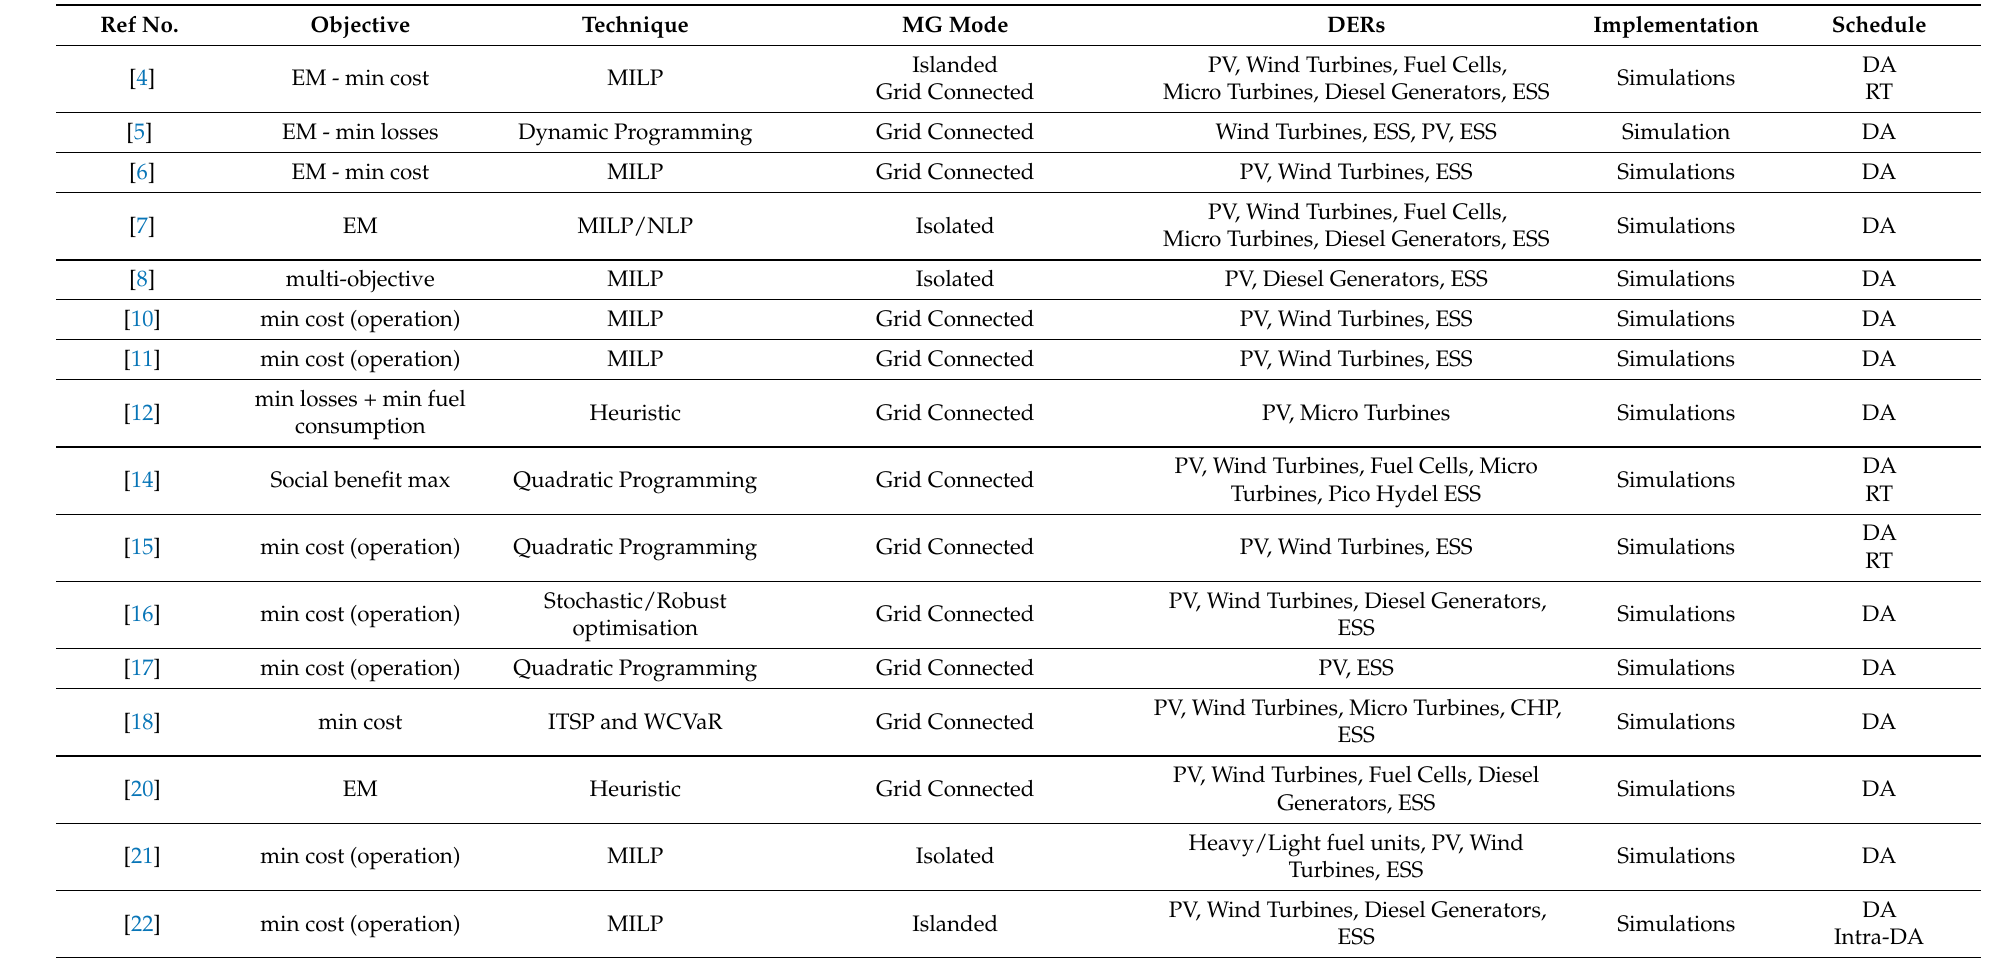
Table 1. Day-ahead MG optimisation